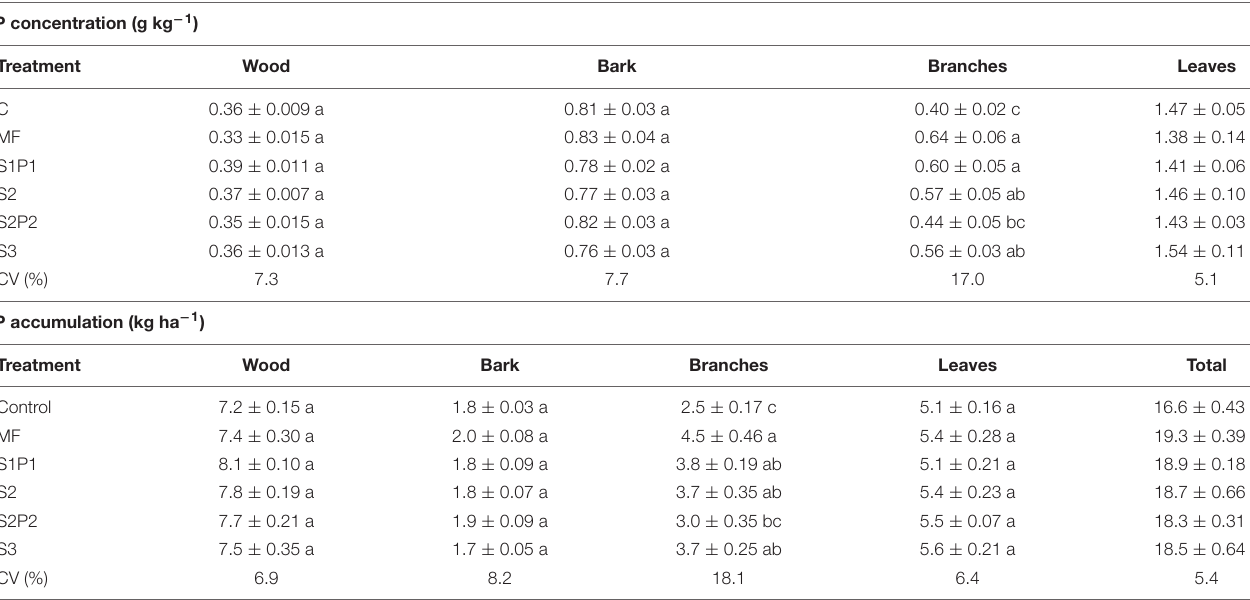
TABLE 5 | Concentration and accumulation of P in 22-month-old E. urograndis plantation in a soil treated with class B sewage sludge 7 months after planting (mean ± standard error, n = 4). P concentration (g kg − 1